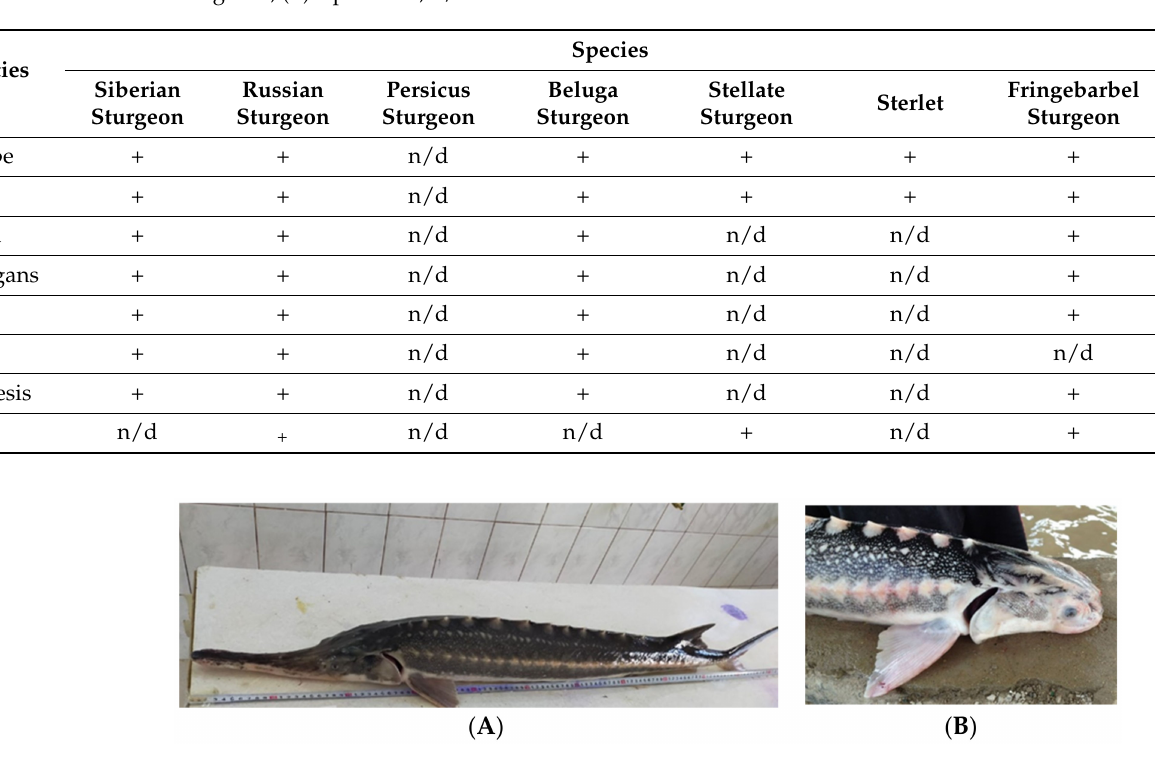
Figure 1. Stellate sturgeon Acipenser stellatus , Ural-Atyrau sturgeon hatchery (Kazakhstan), 1+ age, ( A ) standard fingerling morphology, ( B ) absence of rostrum due to mechanical damage.